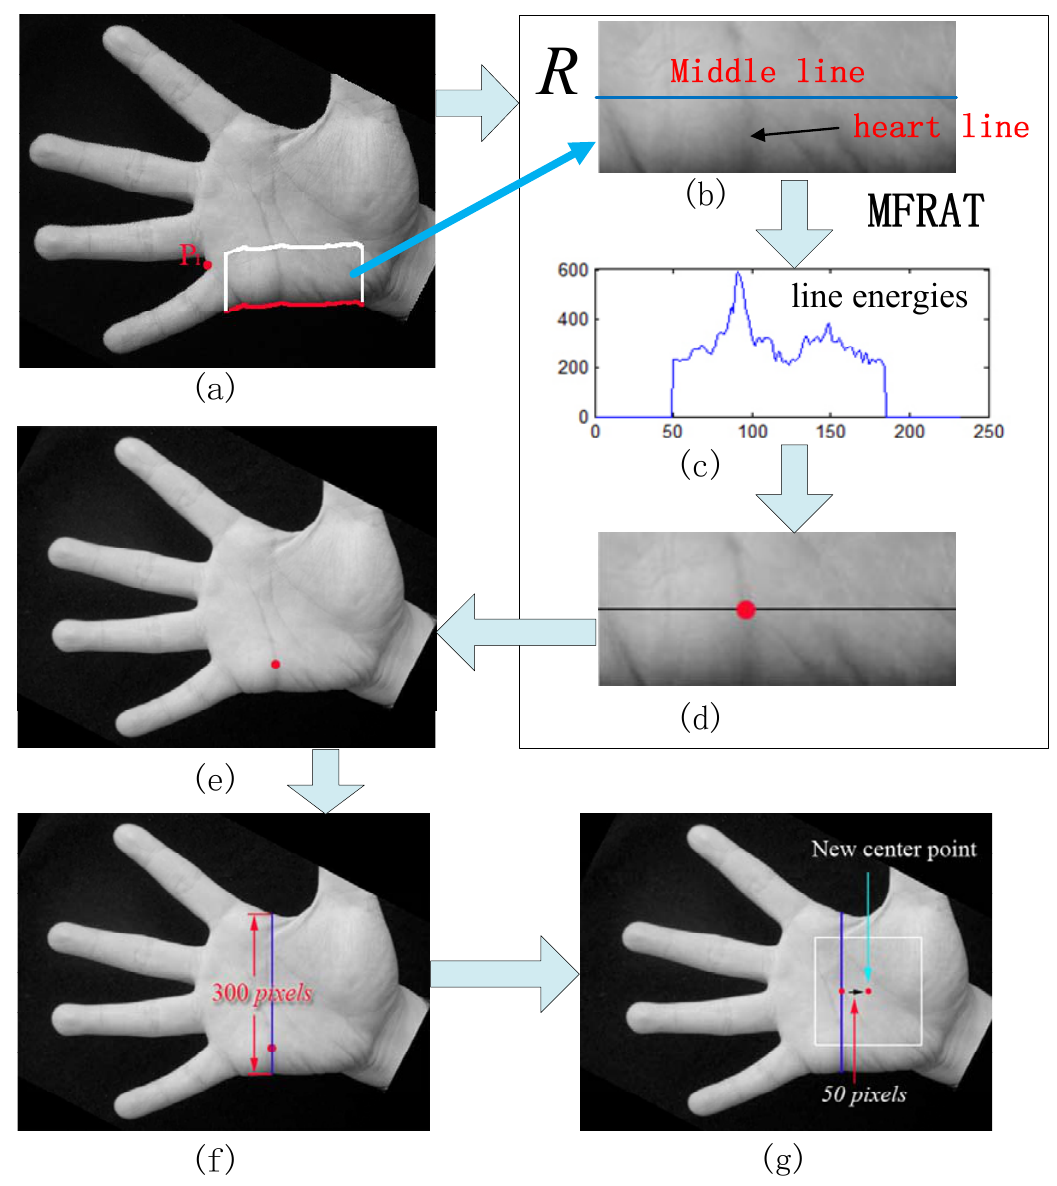
Figure 7. Main steps of the scale normalization algorithm: ( a ) determine a segment of palm boundary around the start point of heart line, and then a rectangle image R above the segment is extracted; ( b ) the rectangle image R; ( c ) the line energies across the middle line; ( d ) the detected point (red point) in R; ( e ) the detected point (red point) in the whole palmprint image; ( f ) all palmprint images are resized to have the same height (300 pixels) in the detected point position; ( g ) crop the ROI image.